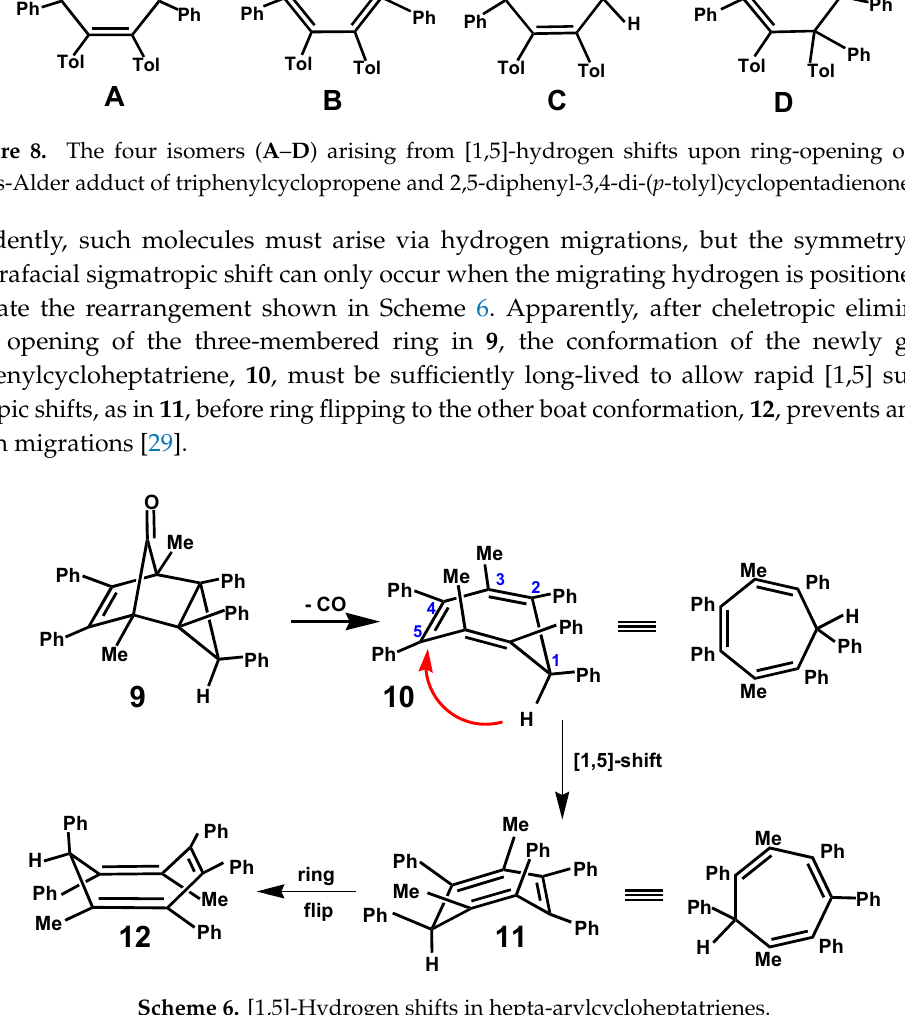
Figure 8. Molecules 2020 , 25 , x FOR PEER REVIEW